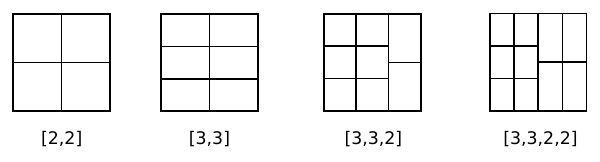
Fig. 2. Examples of the space-filling curve load balancing algorithm, with the Hilbert (left panel), meandering Peano (middle panel) and Cinco (right panel) curves; image from Dennis (2007).